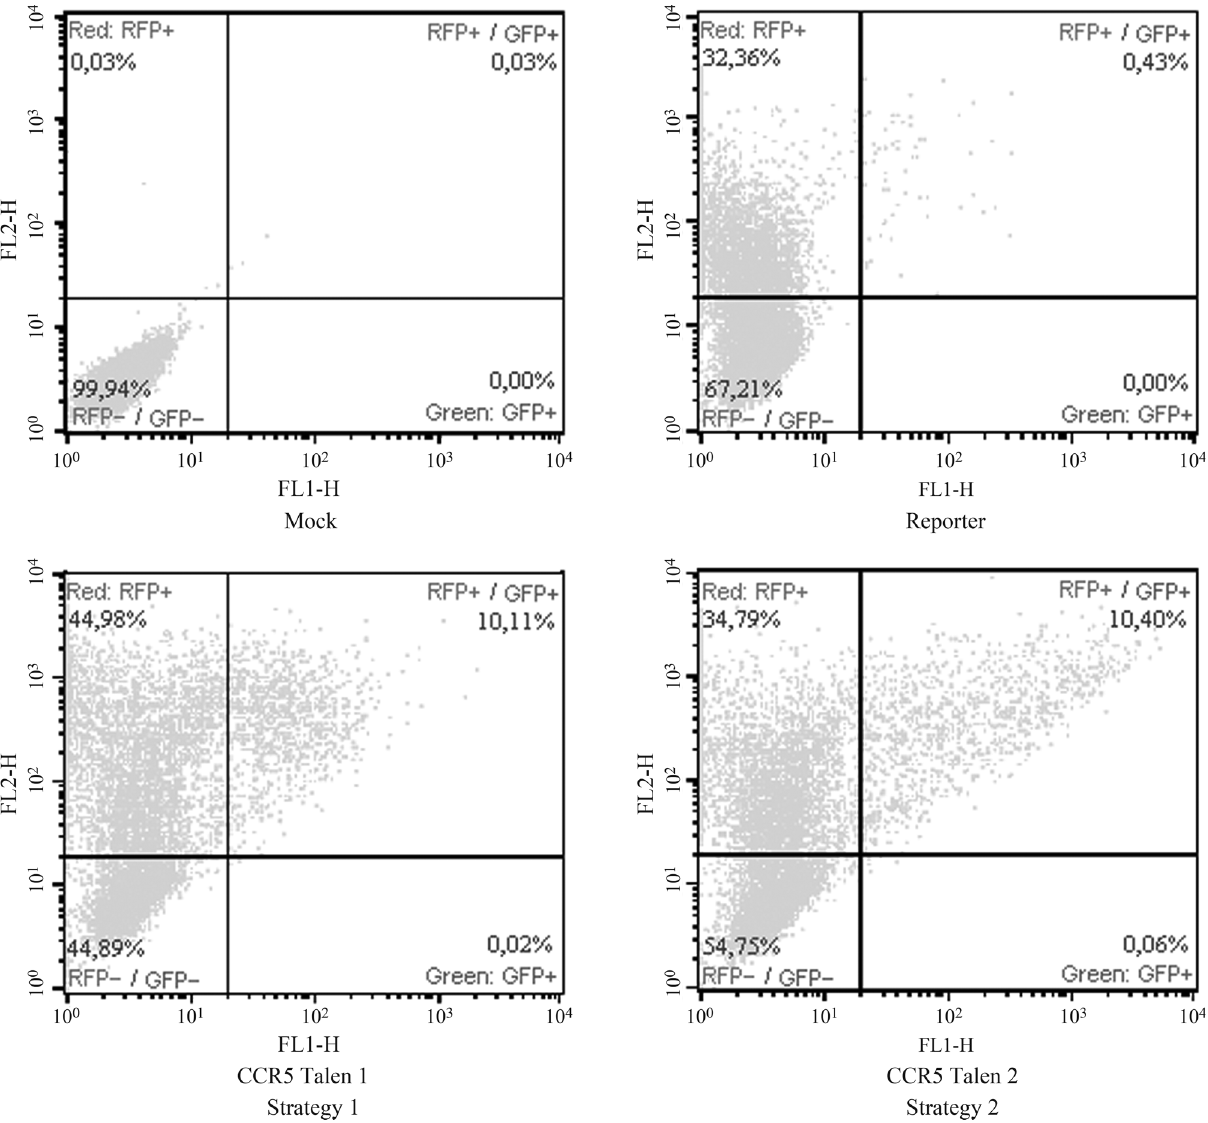
Figure 3 - Flow cytometry after transfection of TALEN-containing plasmids that target two distinct CCR5 first exon positions. Mock transfection was done solely with Lipofectamine 2000 (Invitrogene). The reporter transfection was done with Lipofectamine 2000 and the pRGS-CR reporter plasmid. Strategy 1 transfection was done with Lipofectamine 2000, the pRGS-CR reporter plasmid and the plasmid that encoded the CCR5 TALEN that targeted position 135 th base pair of the first exon of CCR5 (Mussolino et al. , 2011). Strategy 2 transfection was the same as Strategy 1 except that the plasmid con- tainedaTALENthattargetedposition155ofthefirstexonofCCR5(Miller etal. ,2011).Thepercentagesdepictedrepresentthepercentageofcellsgated in each quadrant of the flow cytometry